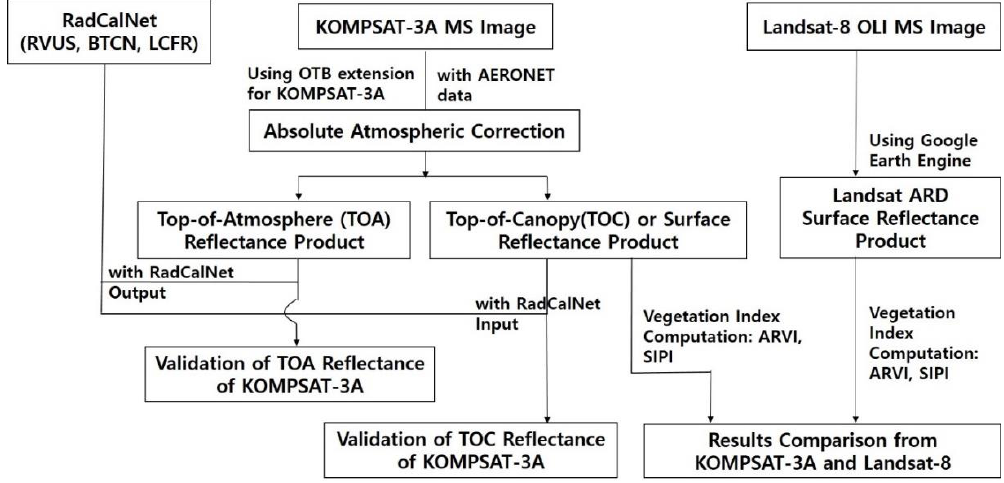
Figure 1. Work flow of the validation of KOMPSAT-3A images and comparison experiments with Landsat-8 Analysis Ready Data (ARD).